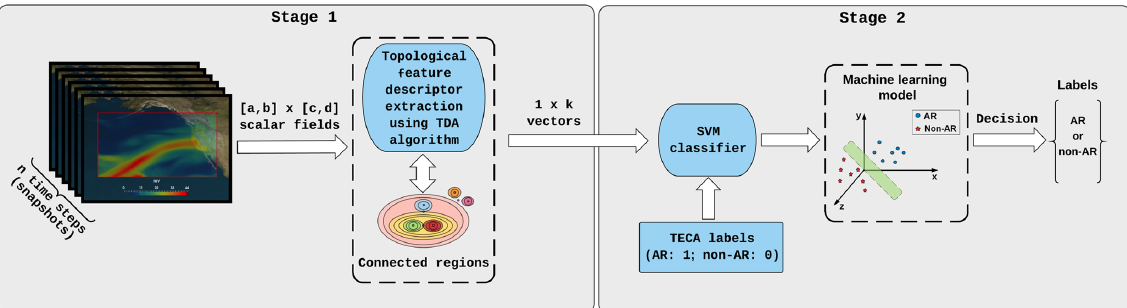
Figure 2. Block diagram of the AR pattern recognition method. Stage 1: the input of the method is a set of scalar fields ( n snapshots) of size [ a,b ]×[ c,d ] on the latitude–longitude grid, where a , b , c and d are the dimensions of grid spatial extent in the real world. The topological data analysis (TDA) algorithm extracts connected regions from the snapshots of global images on the grid. The algorithm maintains the connected regions by varying IWV (referred to as TMQ in CAM5.1) values and dynamically keeps track of the regions in the grid. The connected regions are used as topological feature descriptors that characterize weather patterns (i.e., ARs and non-ARs). The descriptors are 1 × k vectors, where k is greater than the maximal value of IWV/TMQ in a given set of scalar fields (in this case, k = 60). Stage 2: the vectors are stacked on top of each other to form a n × k matrix and are fed into the SVM classifier along with ground truth labels (i.e., AR: 1; non-AR: 0) provided by the Toolkit for Extreme Climate events Analysis (TECA) (Prabhat et al., 2015). Finally, the SVM finds a suitable hyperplane (the green surface shown in the figure) that can cleanly separate events into two groups (i.e., ARs and non-ARs). The output of the method is a set of n labels based on the decision made by the SVM classifier.